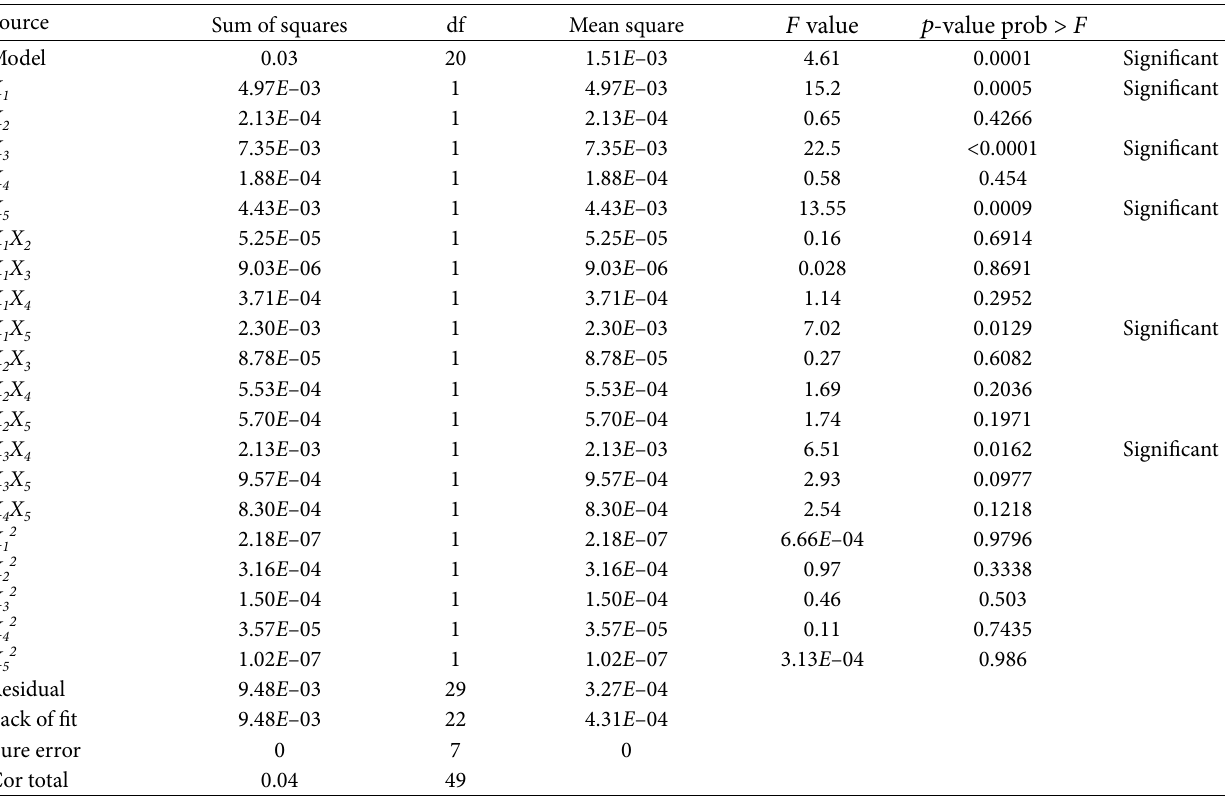
Table 3: ANOVA for Response Surface Quadratic Model.